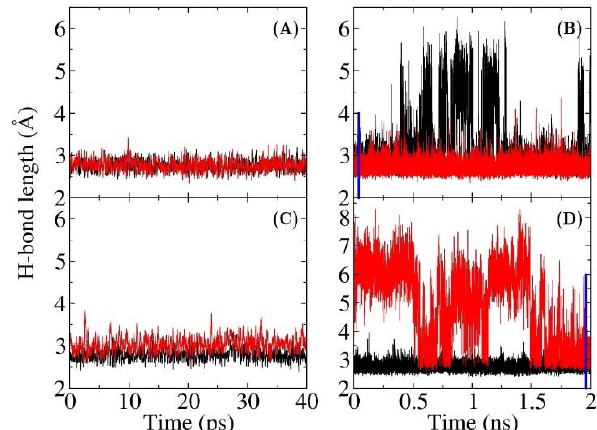
Figure 3. Hydrogen bond length plotted as a function of the MD simulation time. ( A ) and ( B ) are QM/MM and MM simulations, respectively, for the wild type KSI, (black: between OH@Tyr16 and CO@19-NT; red: between OH@Asp103 and CO@19-NT). ( C ) and ( D ) are QM/MM and MM simulations, respectively, for the D103N mutant, (black: between OH@Tyr16 and CO@19-NT; red: between NH@Asn103 and CO@19-NT). The hydrogen bond length is defined by the distance between two O atoms, or the distance between N and O atoms. Blue lines are used to indicate the first 40 ps for WT and the last 40 ps for D103N in ( B ) and ( D ).